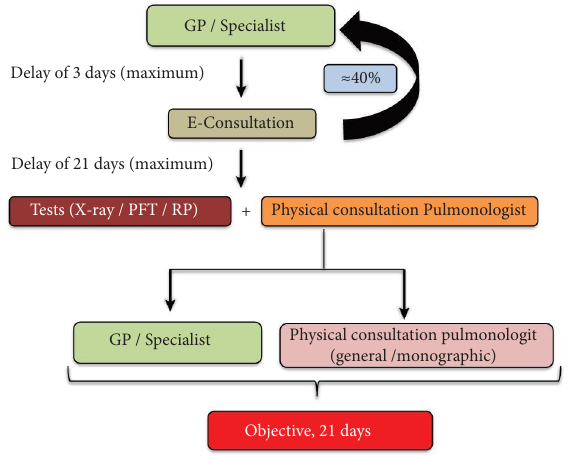
Figure 1: Referral protocol to outpatient pulmonology care since June 2020. Legend. PFT: pulmonary function test; GP: general prac- titioner; RP: respiratory polygraphy; and X-ray: chest